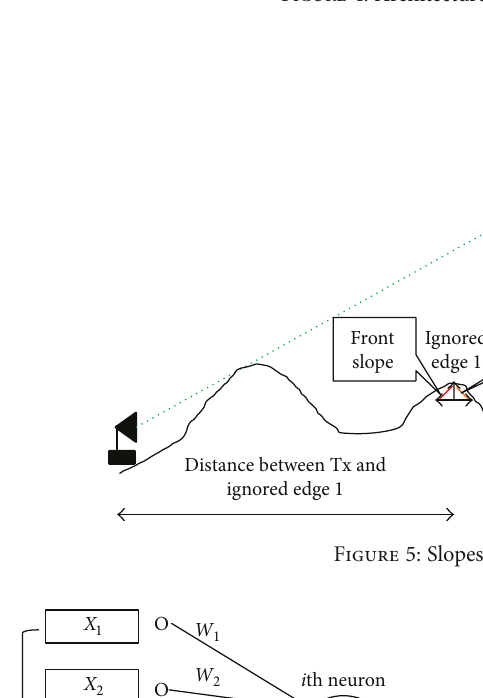
Figure 4: Architecture of the proposed method.